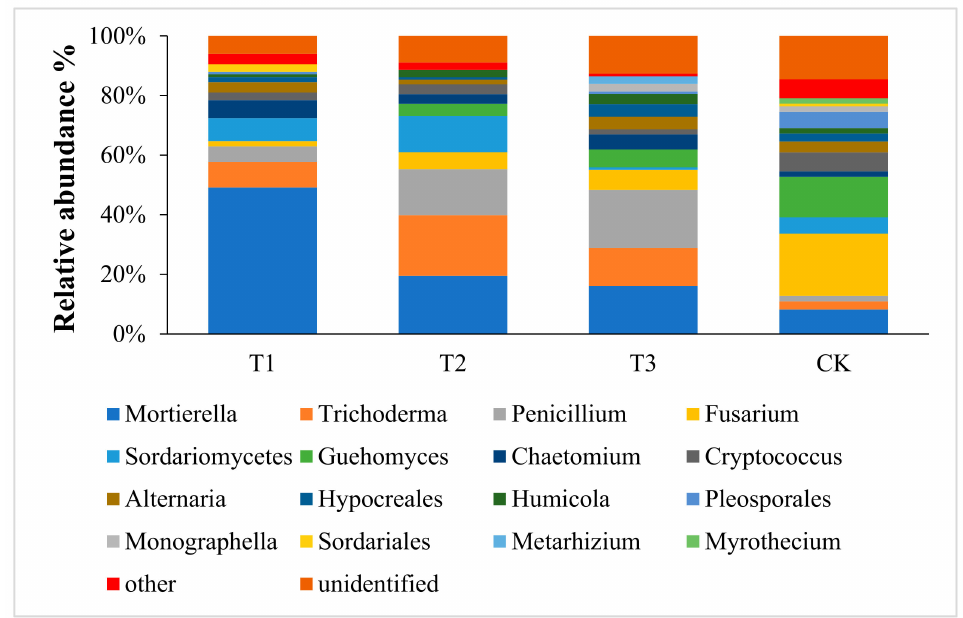
Figure 3. Relative abundances of the fungi in different soil samples at the fungal genus level. T1, the replanted soil fumigated with methyl bromide; T2, the replanted soil mixed cropping with A. fistulosum ; T3, the replanted soil mixed cropping with B. juncea .; CK: the replanted soil. In the fumigated soil, A. fistulosum treated soil, B. juncea treated soil, and replanted soil, Total 116,123,118 and 110 clones were identified, respectively. Relative abundances of fungi >1% were used for analysis. Relative abundances of fungi <1% were classified into